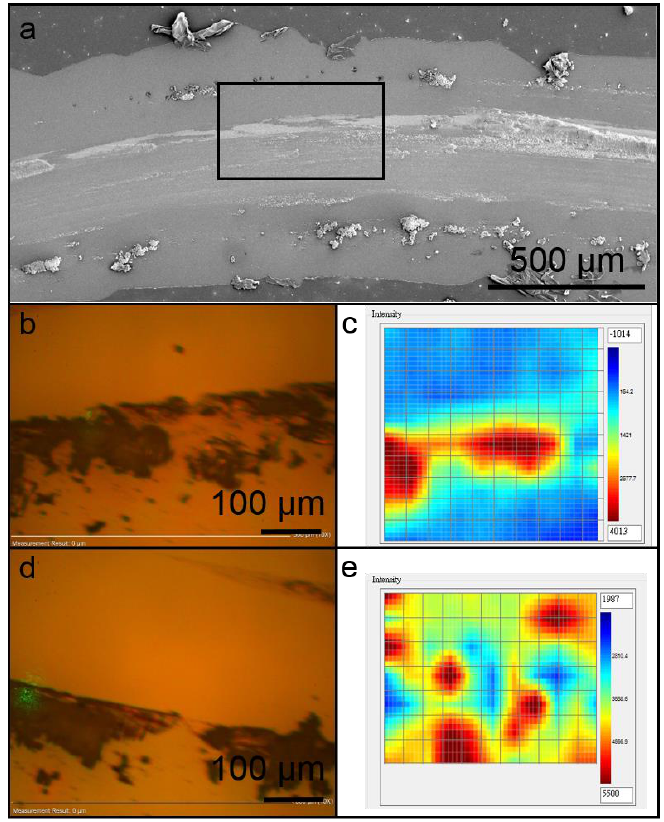
Figure 10. ( a ) SEM image of the wear track; ( b ) OM image of wear scar at a wear distance of 10 m; ( c ) Raman mapping image of ( b ); ( d ) OM image of wear scar at a wear distance of 15 m; ( e ) Raman mapping image of ( d ).